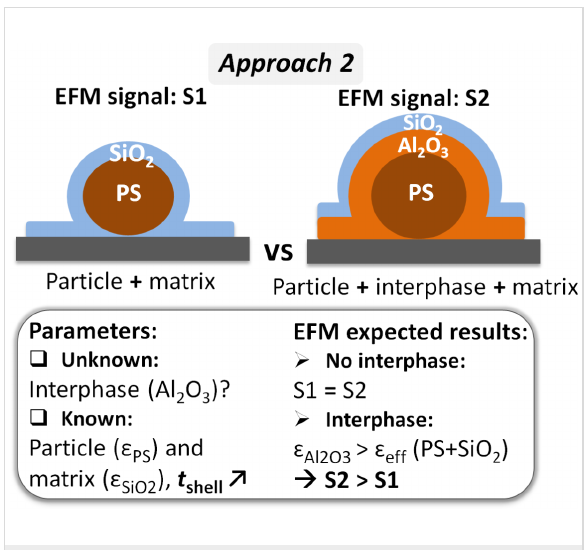
Figure 3: Interphase detection, approach 2: schematic representation of the samples to be compared, and